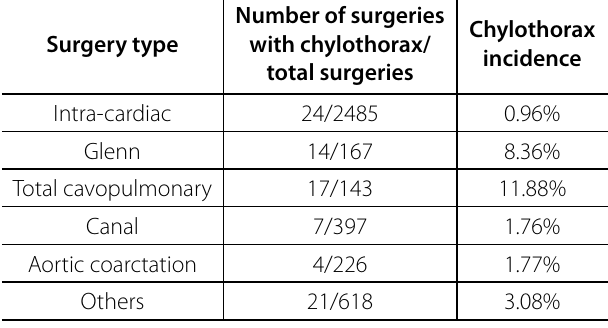
Table 1. Chylothorax incidence by performed